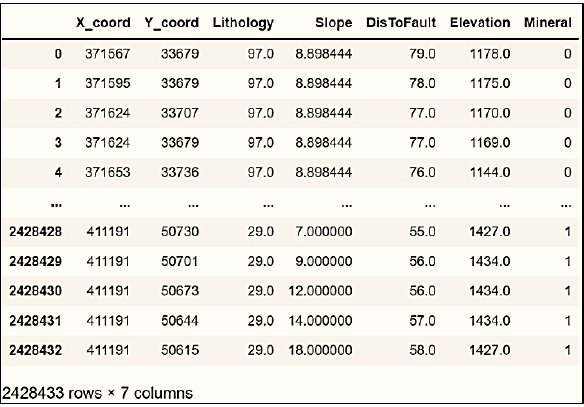
Table 1: Overview of the